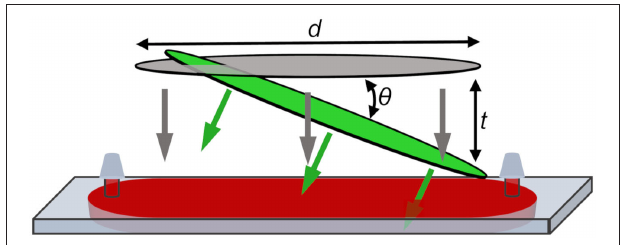
FIGURE 2 | Sample plane in SSTA instrument showing pump (green) and probe (gray) focused to lines. Probe pulse is incident normal to the cuvette. Spatially encoded time delay, t , is generated by the angle of the pump pulse relative to the probe pulse, θ , and the length of overlap between the two pulses, d . Sample is injected into the flow-cell cuvette through septa to prevent solvent evaporation during the